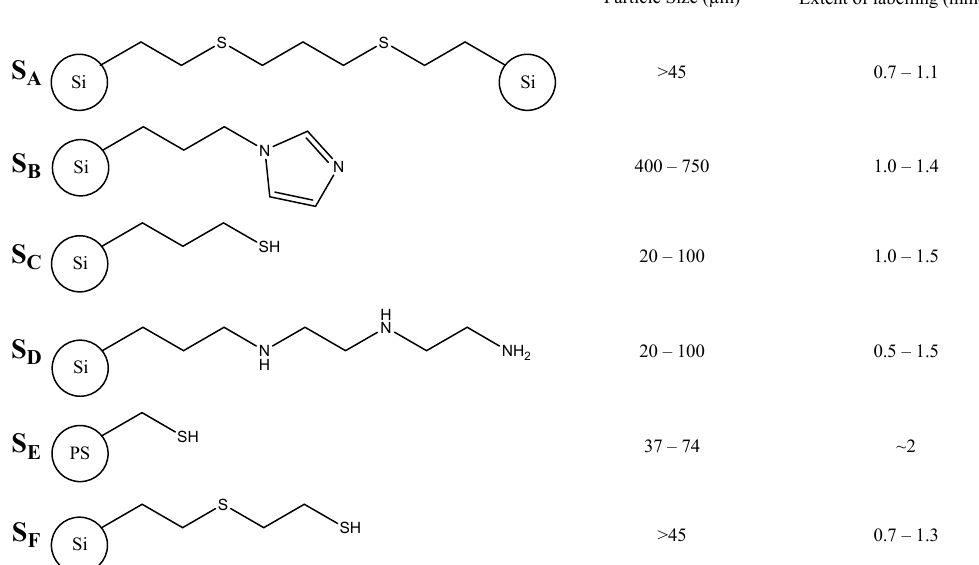
A – S F are silica mounted except S E which is